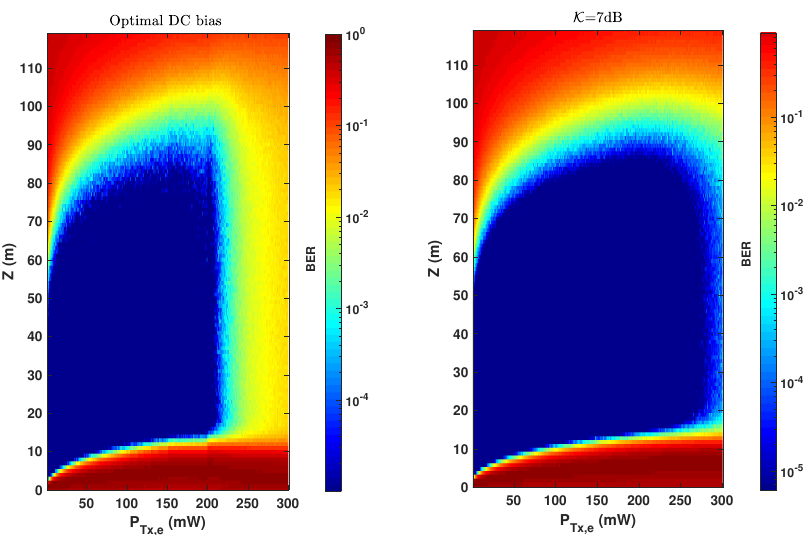
Figure A1. Comparison of the BER performance for DCO-OFDM: left: Optimal DC bias (HP); right: DC bias obtained by setting a clipping factor of 7dB; DC bias obtained by setting K = 7dB but limited to 3.9V. N = 1024; N CP = 9; R b = 20Mbps, η ≈ 1bps/Hz.